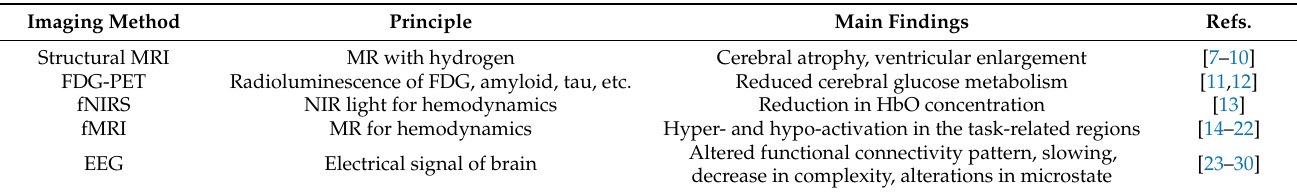
Table 1. Neuroimaging findings in AD